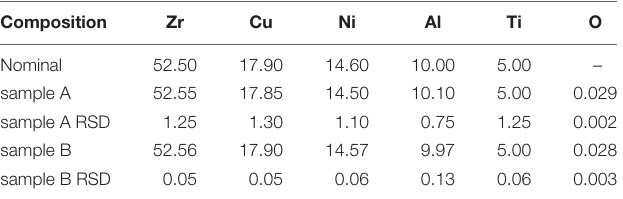
TABLE 1 | Results of chemical analyses of Vit 105 BMG samples prepared by routes A and B: element analysis (ICP-OES in at.%) and carrier gas hot extraction oxygen analysis (in wt.%).